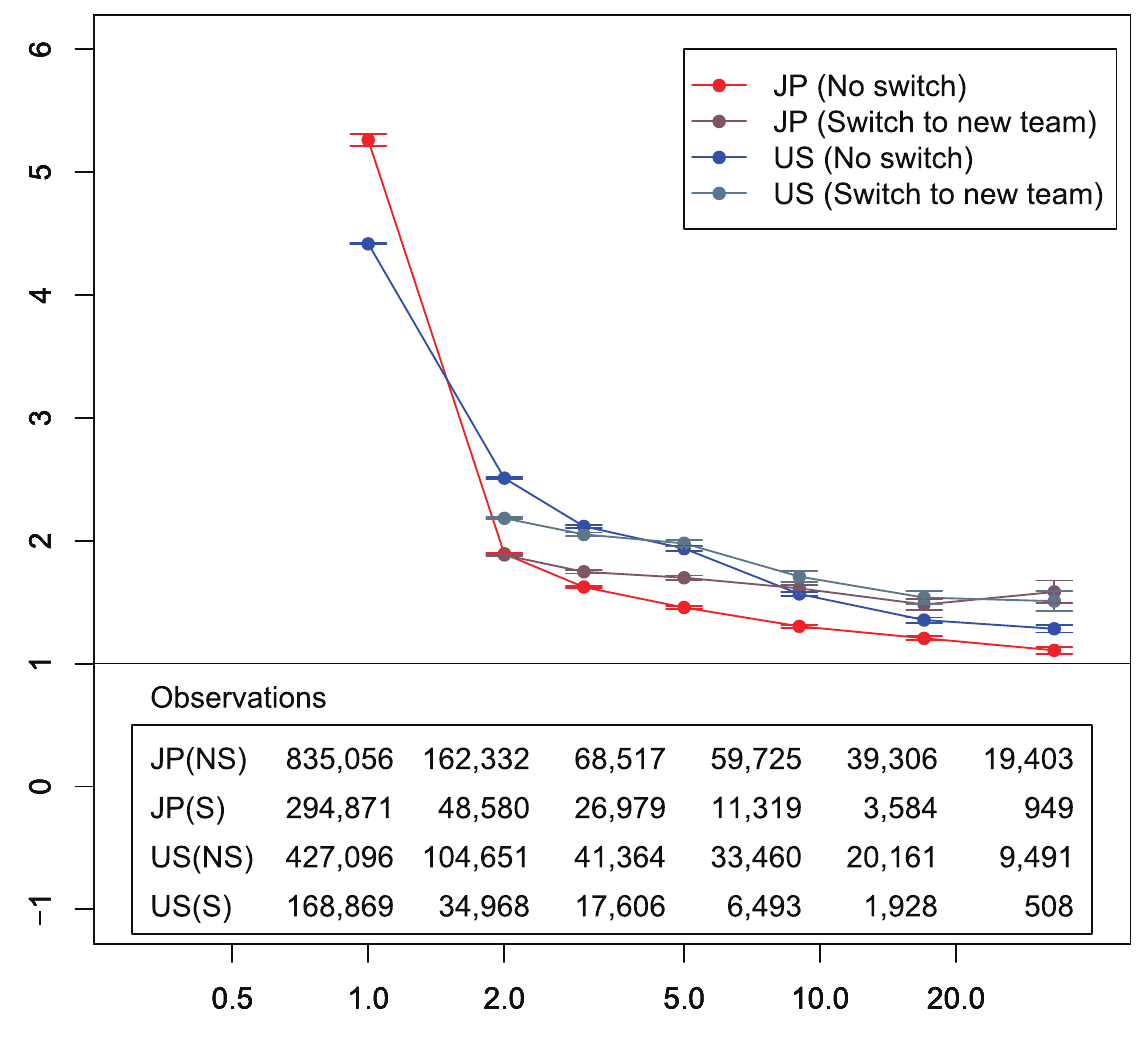
Fig 6. Average impact of patents following hits. We define hits as patents with top 10% impact. Horizontal axis is number of patents including a hit and all subsequent patents by the same team that made the hit. The hit is not necessarily the team ’ s first patent. Vertical axis is average impact. Horizontal axis is cut so that number of samples is greater than approximately 100. Red, grayish red, blue, and grayish blue lines correspond to Japanese “ no switch, ” Japanese “ switch to new team, ” U.S. ’ s “ no switch, ” and U.S. ’ s “ switch to new team. ” Brackets show standard errors. Black horizontal line is impact =